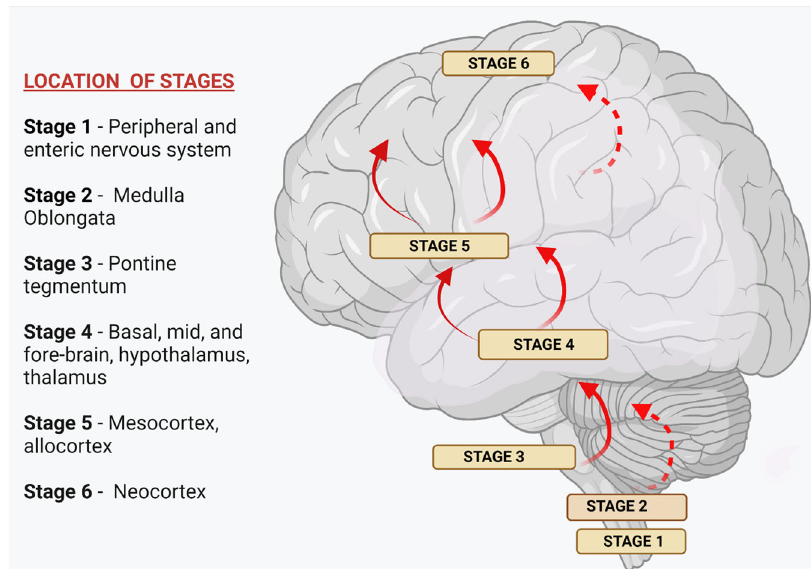
Fig. 1 Braak-staging of Lewy pathology in PD. Braak et al., 2003 suggested a six staged course of Parkinson ’ s illness 203 . As per this concept, α -synuclein accumulates particularly in cerebral areas as well as in neuronal areas, resulting in Lewy pathogenesis throughout a stereo typical, sequential behavior which steps up caudo-rostrally. In its fi rst stage, Lewy pathogenesis starts through the lower midbrain (along with the dorsal motor nucleus of the vagus nerve in the medulla), then to the coeruleus-subcoeruleus complex, raphe nuclei, giganto cellular reticular nucleus in the anteromedial temporal mesocortex, cingulate cortex, and later to the neocortical structures. The illness is thought to initiate in the peripheral and spread to the CNS. With the extent of this Braak stage, the extent of infections in the sensitive areas worsens, and the illness progresses 203